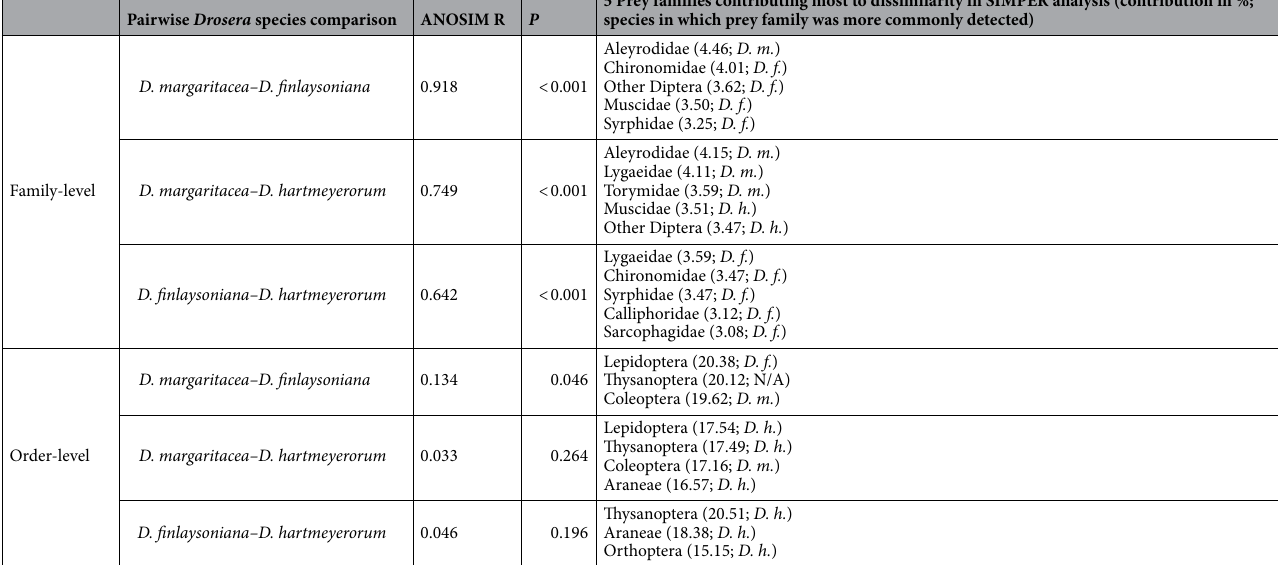
length of the three species (0.81 ± 0.29; Fig. 4).